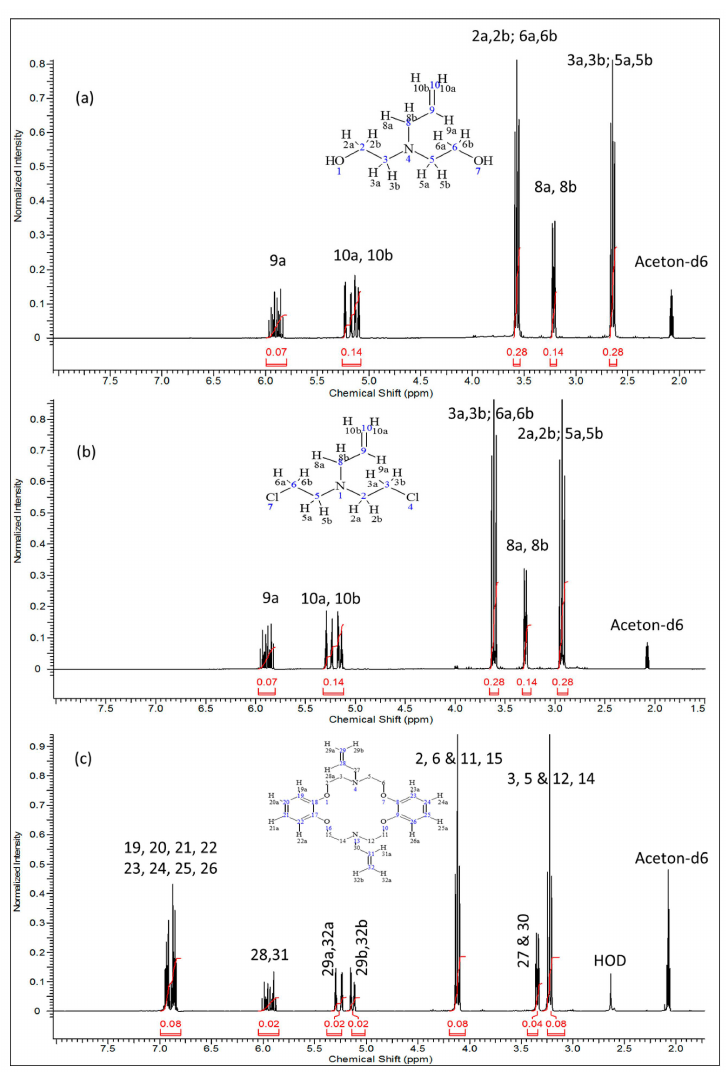
Figure 2. 1 H-NMR spectra of: ( a ) 2,2 1 -(prop-2-en-1-ylimino)diethanol ( 2 ) ( b ) N , N 1 -bis(2-chloroethyl) prop-2-en-1-amine ( 3 ); and ( c ) N,N 1 -diallyl-7,16-diaza-1,4,10,13-tetraoxa-dibenzo-18-crown-6 ( 4